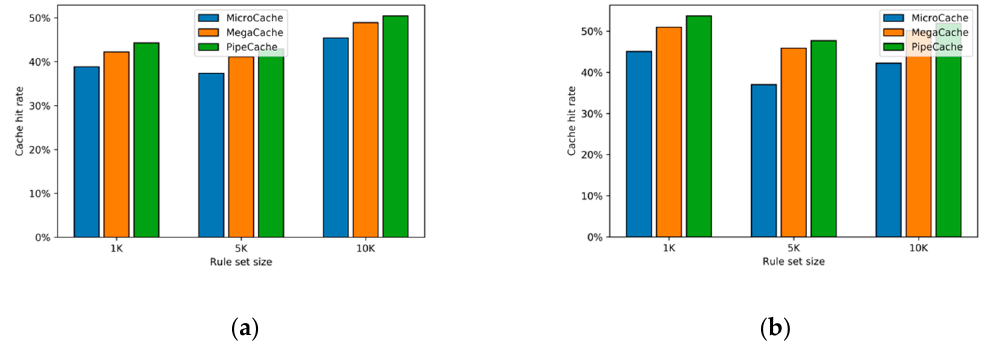
Figure 7. Cache hit rates with different ruleset sizes. ( a ) OF1-seed. ( b ) OF2-seed.